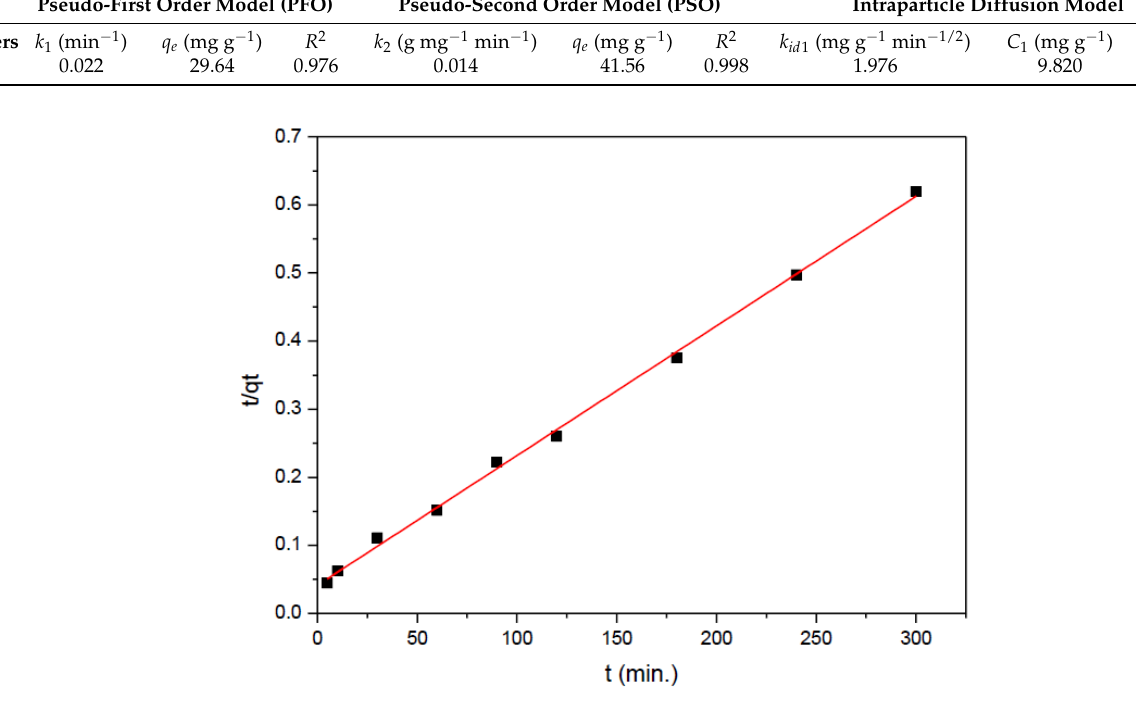
Figure 5. Pseudo second-order kinetic plots for adsorption of selenate onto A-LMS Fe 3 O 4.